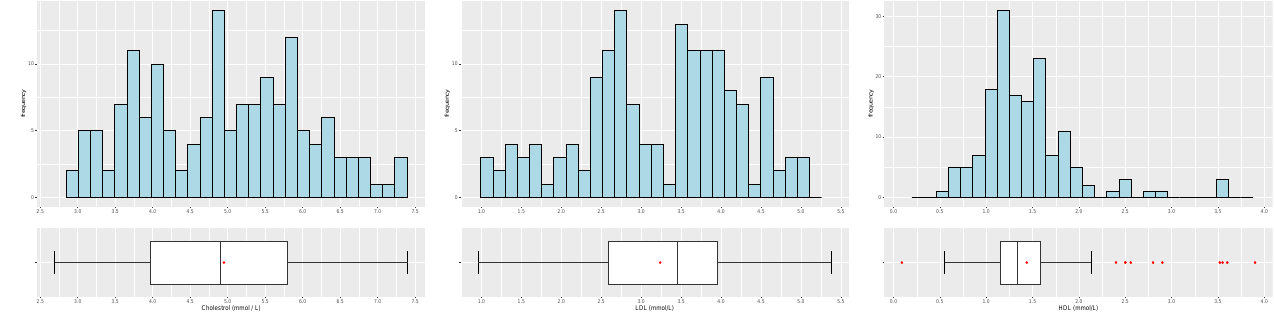
Figure 7. Distribution of the patients by cholesterol ( left ), LDL ( center ) and HLD ( right ).